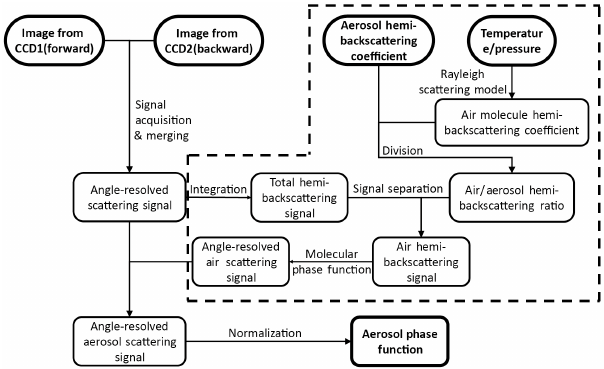
Figure 4. Flow chart of the retrieval algorithm used to determine aerosol phase function from CCD-LADS measurements (the pro- cesses in the dashed box are used to subtract the scattering signal of air molecules from the total scattering signal).